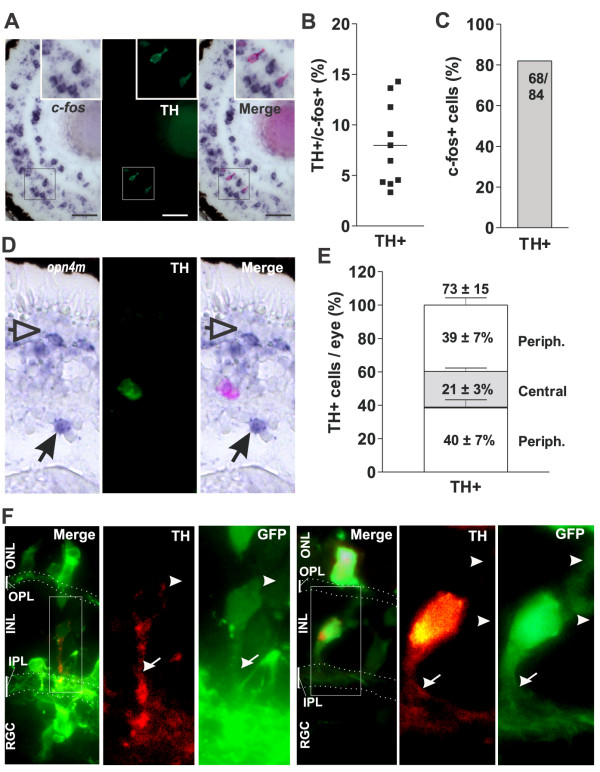
Amacrine tyrosine hydroxylase (TH)-positive cells express c-fos in response to light and localize mainly in the peripheral retina. (A)In situ hybridization against c-fos of a central retinal section from a Stage 42 tadpole exposed to light (2500 lux, 30 minutes) followed by immunohistochemistry against TH. Insets show higher magnification of a c-fos+ / TH + cell. (B) Percentage of TH + cells relative to the total number of c-fos + cells in each central retinal section is indicated by a dot; the horizontal line represents the mean (n = 10). (C) Percentage of TH + cells exhibiting c-fos induction by light. The number of cells counted is indicated. (D) Transverse section of the eye from a Stage 42 tadpole showing a representative in situ hybridization label for opn4m and immunohistochemistry results for TH. Merge image is shown in the right panel. mHC (arrowheads) and mRGC (arrows) are indicated. (E) Distribution of TH + cells counted in consecutive sections throughout the whole eye, divided into two peripheral areas and one central area. The percentage of the cells located in each region and the total numbers of cells counted (mean ± SD; n = 3 eyes) are indicated. (F) Morphology of the TH + cells. Stage 28 embryos were electroporated with a GFP construct. At Stage 42, Double-positive cells (TH + and GFP+) were revealed by immunohistochemistry. Examples of two cells are shown, with the merged image shown on the left, and the higher magnification of the TH + (red) and GFP (green) cells shown in the right panels. Neurite extensions (TH+ / GFP+; arrow) oriented to the inner plexiform layer (IPL), and neurites (TH− / GFP+; arrowhead) oriented to the outer plexiform layer (OPL), are indicated. The IPL and OPL are shown by dots. INL, inner nuclear layer; ONL, outer nuclear layer; RGC, retinal ganglion cell layer.